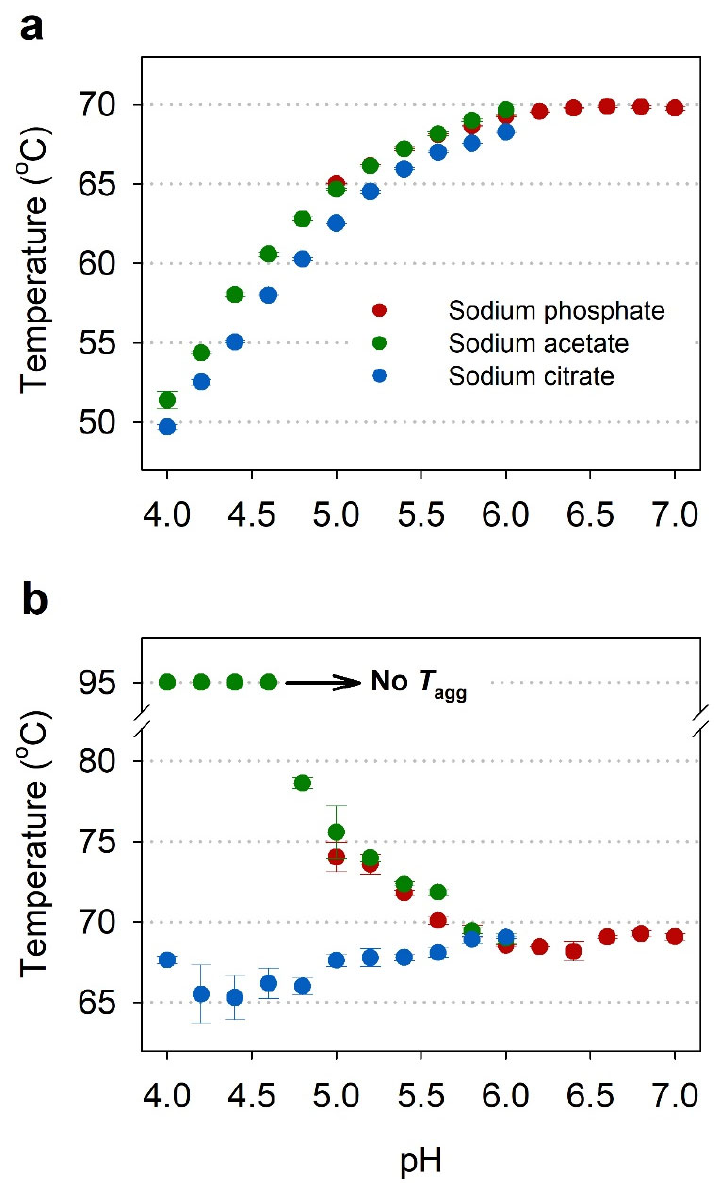
Figure 3. Effect of pH and buffer species on T m ( a ) and T agg ( b ) of IgG in three different buffers (red—sodium phosphate; green—sodium acetate; blue—sodium citrate), as measured by nanoDSF. ( a ) Graph of T m of IgG as a function of pH; ( b ) Graph of T agg of IgG as a function of pH. All samples were set at a concentration of 1 mg/mL and values are the mean and standard deviation of triplicate measurements.